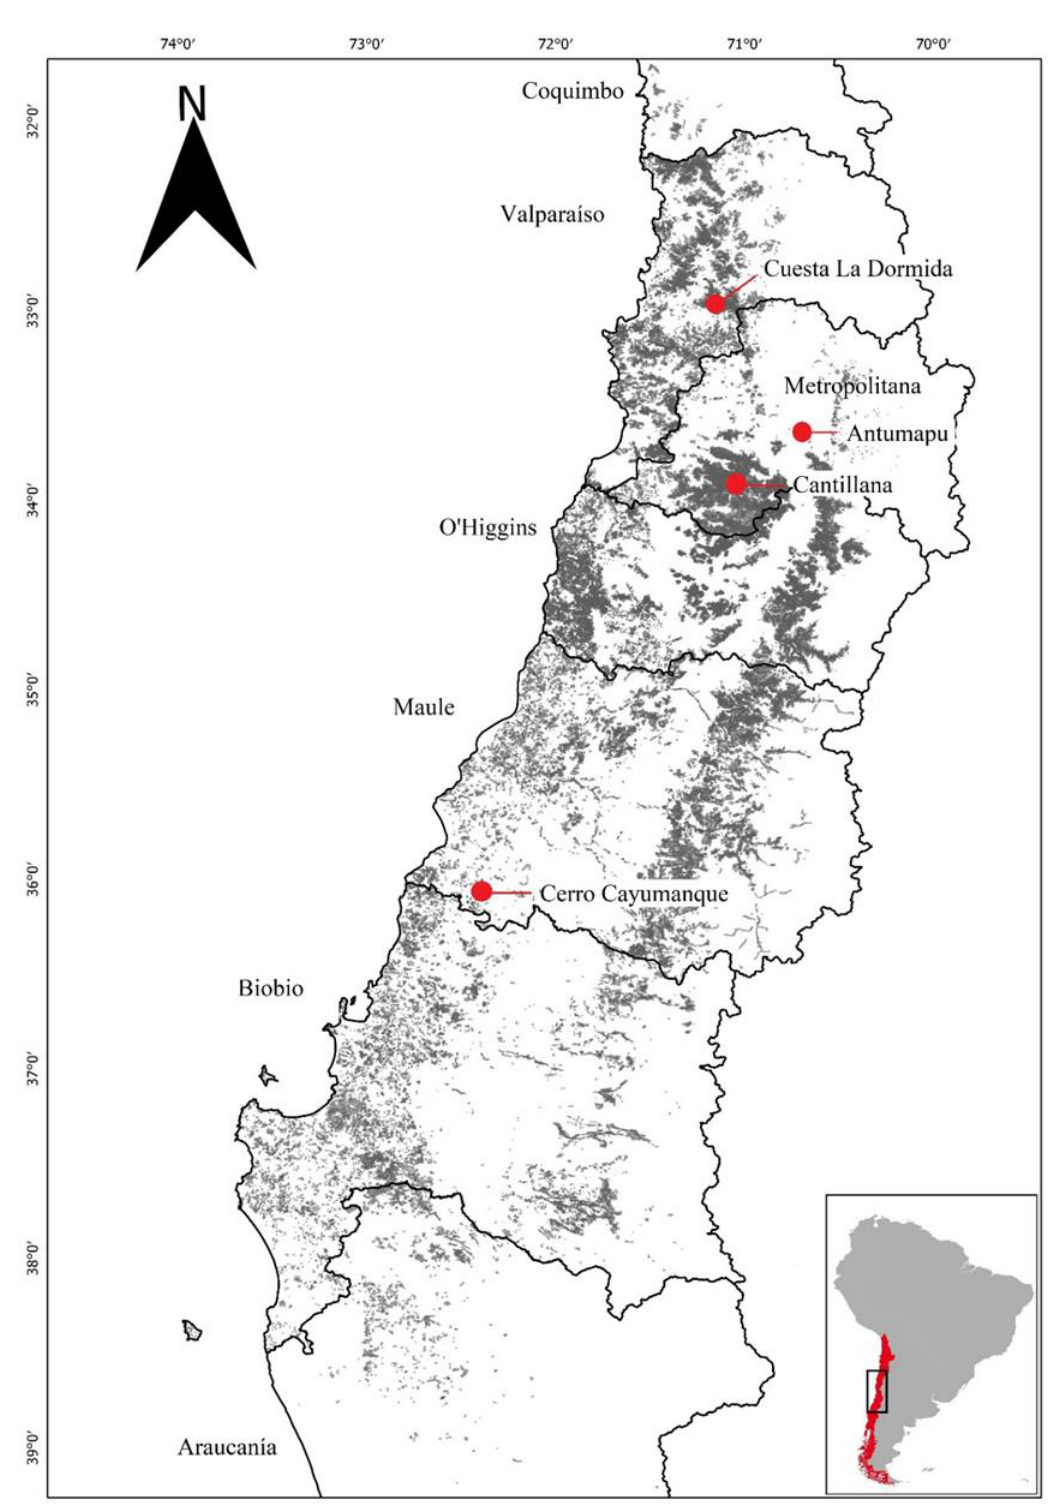
Figure 2. Location of the seed sources of Cryptocarya alba (Molina) Looser under study.